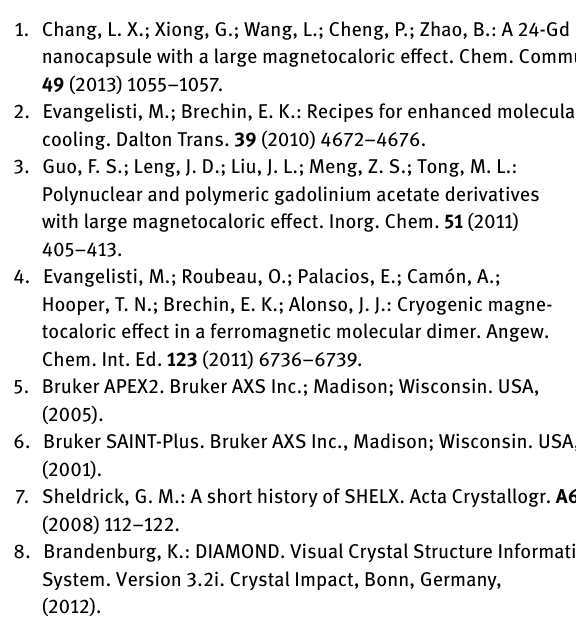
groups. Consequently, the two Gd 3 + atoms are in the same coordination environment and each Gd 3 + ion is nona- coordinated by N and O of the three different ligands ( cf . the figure). Each Gd(C 7 H 9 O 2 N)(C 5 H 3 ONCl) 2 (NO 3 ) unit is bridged by two 6-chloropyridin-2-olato ligand to give a Gd-Gd separation of 3.956 Å. The Gd(1)—Gd(1A)—O(9)— O(9A) bridging unit is planar. The Gd(1)—O(9)—Gd(1A) and O(9)—Gd(1)—O(9A) angles in the bridge are 111.49° and 68.51°, respectively. The distances of O(9)—Gd(1) and O(9)—Gd(1A) are 2.329 Å and 2.457 Å, respectively. The crystal packing doesn’t exhibit hydrogen bonds or classical